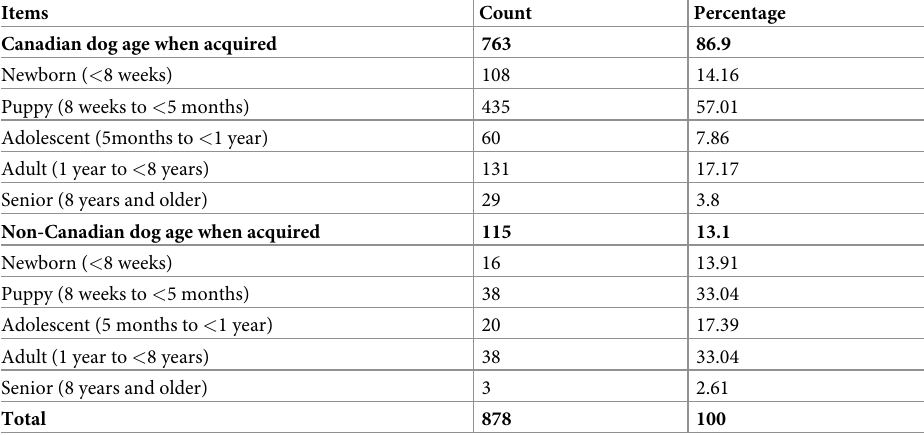
Table 17. Canadian and non-Canadian dog age on acquisition.